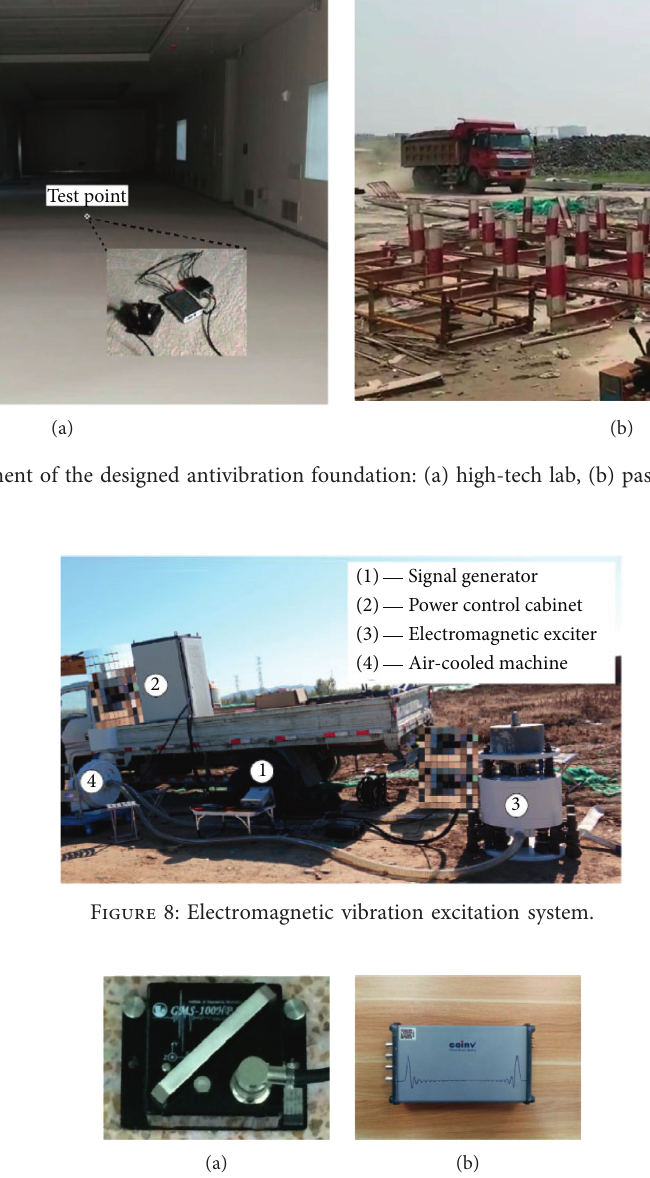
Figure 9: Data acquisition instruments: (a) GMS-100HP-T sensor, (b) data acquisition